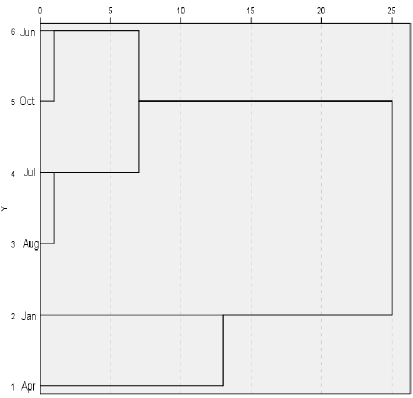
Figure 5. Cluster analysis of temporal variation in the six sampling months.